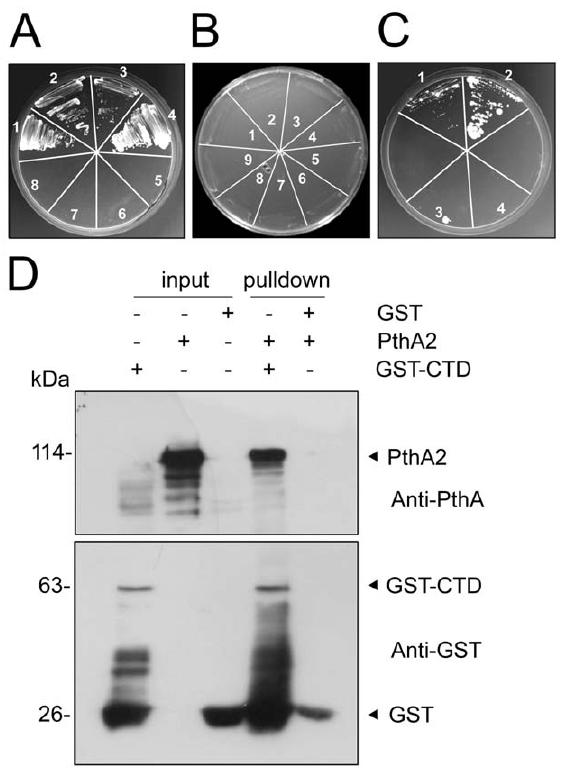
Figure 3. PthA variants interact with the CTD through their LRR region. (A) Yeast two-hybrid assay showing the interaction between the CTD and the four PthA variants (1–4, respectively). Yeast cells co- transformed with the individual pOAD-PthA 1–4 constructs plus empty pOBD (5–8, respectively) were used as controls. (B) No interactions were observed between each of the repeat domains (RDs) of the PthA variants 1–4 (1–4, respectively) with the CTD. Yeast cells co-transformed with the bait pOBD-CTD plus empty pOAD (5) or the preys pOAD-RD 1– 4 plus empty pOBD (6–9, respectively), as controls, are indicated. (C) Yeast two-hybrid interactions of the CTD with the truncated version of PthA2 carrying 5.5 internal repeat units plus the C-terminal domain (1) or the LRR region alone (2). Control yeast cells co-transformed with empty pOBD plus the prey constructs pOAD-5.5rep + CT (3) and pOAD- LRR (4) are indicated. (D) GST-pulldown assay using the GST-CTD as bait and purified PthA2 as prey. Protein samples were electrophoresed and probed with the anti-GST and anti-PthA sera. PthA2 bound to the GST- CTD but not to GST alone. Soluble cell extracts of GST-CTD, GST alone and the purified PthA2 used as inputs are indicated and the molecular sizes of the corresponding proteins are shown on the left.